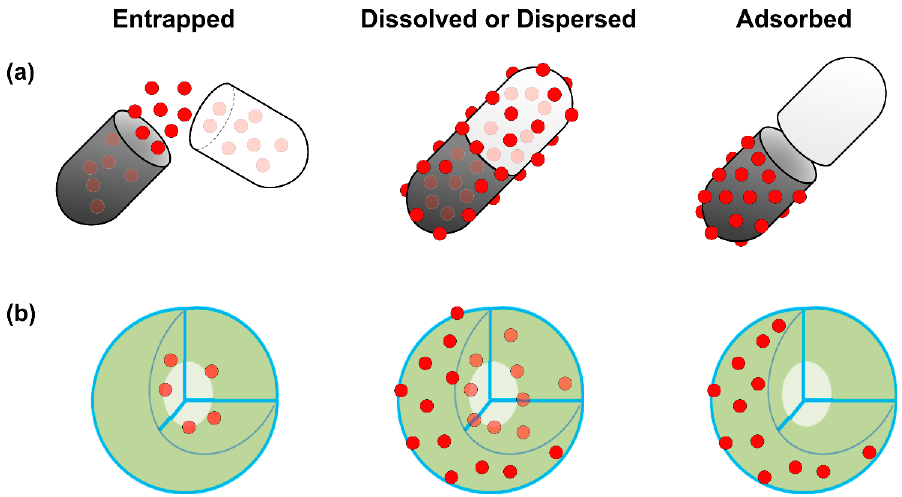
Figure 6. Encapsulation mechanism models: drug entrapped in, dissolved in, or dispersed within and adsorbed on: ( a ) nanocapsules and ( b ) nanospheres [67].